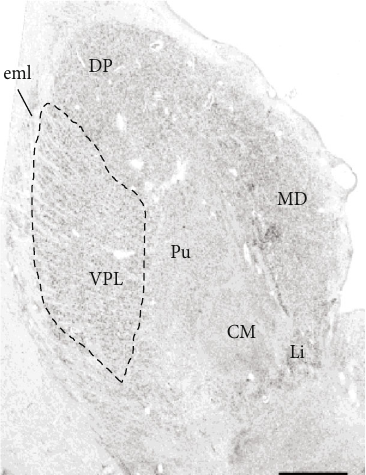
Figure 1: Thalamus drawing with subregions. Anterior (principal) nucleus (AN) reciprocally connected with the anterior cingulate cortex (ACC), mediodorsal nucleus, parvocellular subregion (MDNp) reciprocally connected with dorsolateral prefrontal cortex (DLPFC), and ventroposterior lateral nucleus (VPL), a lateral tier nucleus.